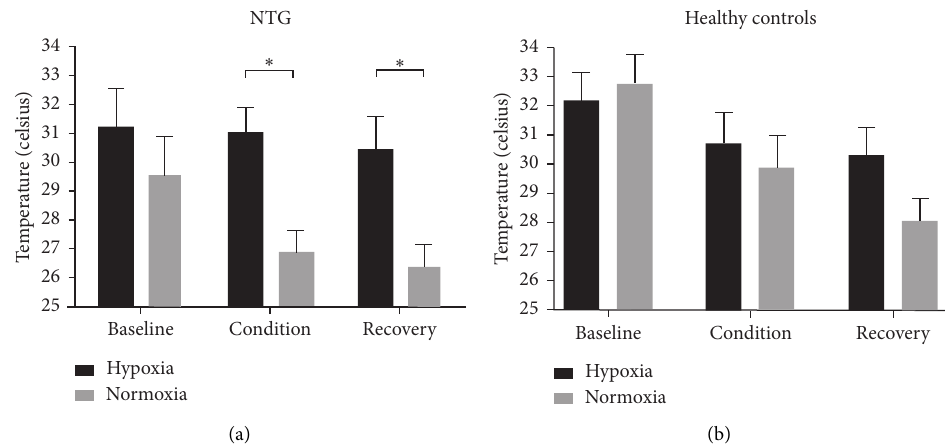
Figure 5: Overview of thermographic data. The distal finger temperature was significantly higher after two hours of hypoxia compared to two hours of normoxia, as well as during recovery, for patients with NTG. No significant differences were seen for age-matched healthy controls (statistics: two-way ANOVA, Sidak’s multiple comparisons test).